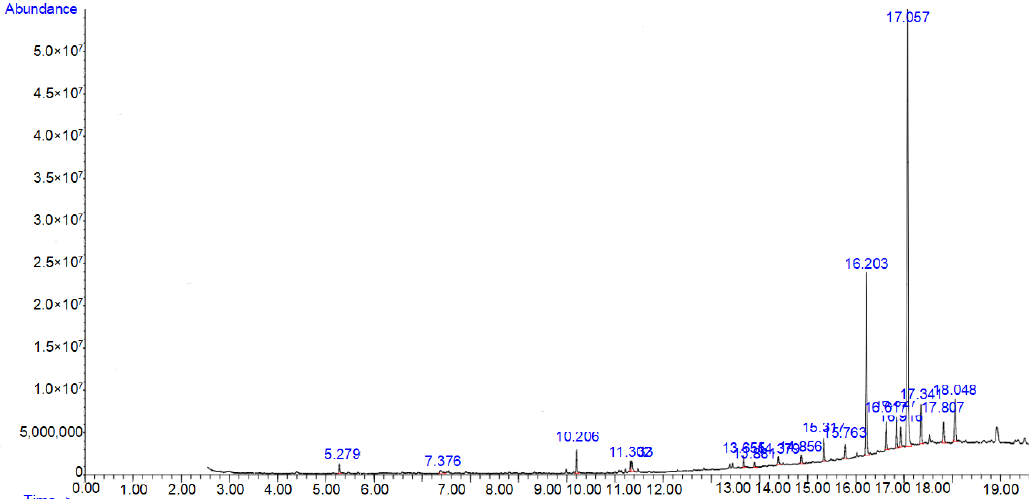
Figure 1. GC-MS chromatogram of methanolic extract of Caralluma edulis plant. The chemical compounds with their molecular formula, retention time, and peak area percentage are presented in Table 1. Table 1. Phytoconstituents in the methanol extract of Caralluma edulis plant as detected by GC-MS analysis.